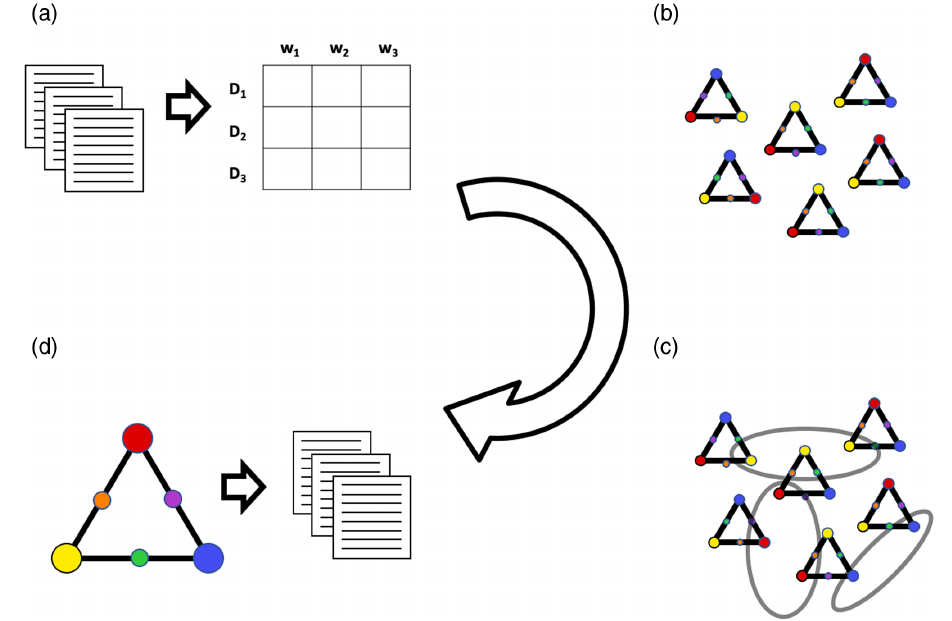
FIG. 3. Flowchart diagram of methods: (a) Data collection and preprocessing; (b) Repeated topic modeling across filtering parameters, number of topics, and α values; (c) Aggregation and clustering of topics; (d) Analysis of literature with final